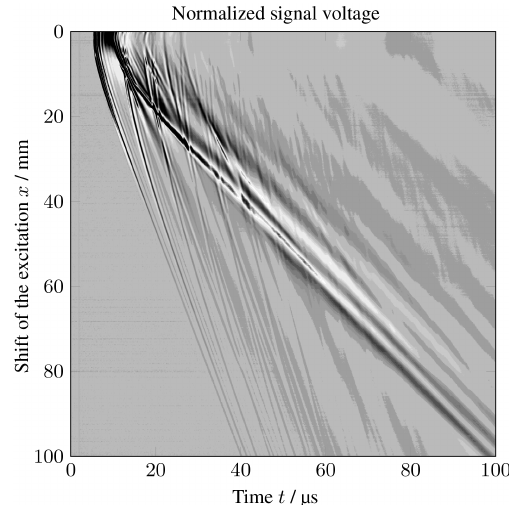
Figure 8. Measurement data (normalized signal voltage) with tem- poral and spatial resolution. Generated by moving the focus of the laser away from the transducer in equidistant steps. The specimen is a polyamide 6 plate, thickness is 8.8mm.